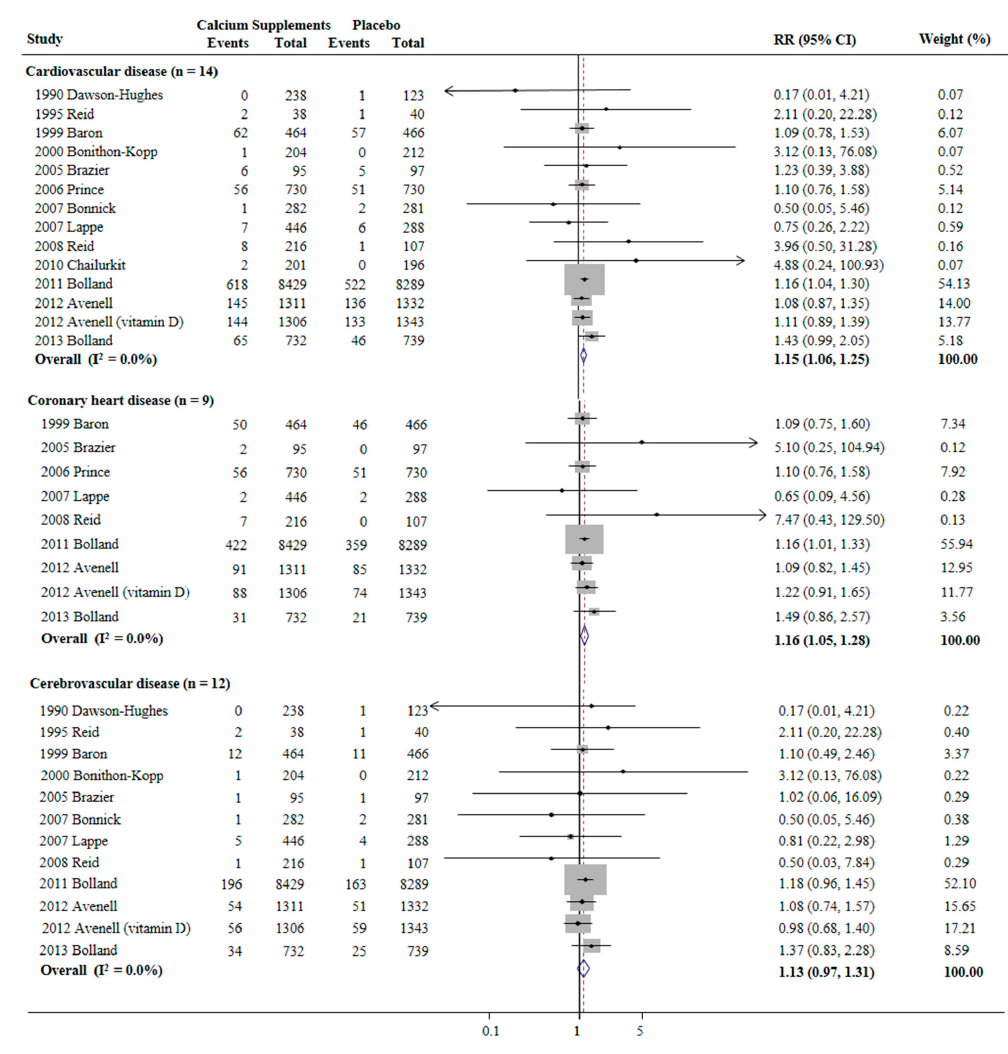
Figure 2. Use of calcium supplements and risk of cardiovascular disease in a random-effects meta-analysis of randomized controlled trials. RR, relative risk; CI, confidence interval. Avenell et al.’s trial [25] used both calcium alone and calcium plus vitamin D in the supplementation groups. Thus, a total of 14 trials were included in the analysis. Publication bias was not observed: the Begg’s funnel plots were all symmetrical, and p for bias was 0.81 for CVD, 0.81 for CHD, and 0.32 for cerebrovascular disease in the Egger’s test (Figure 3).